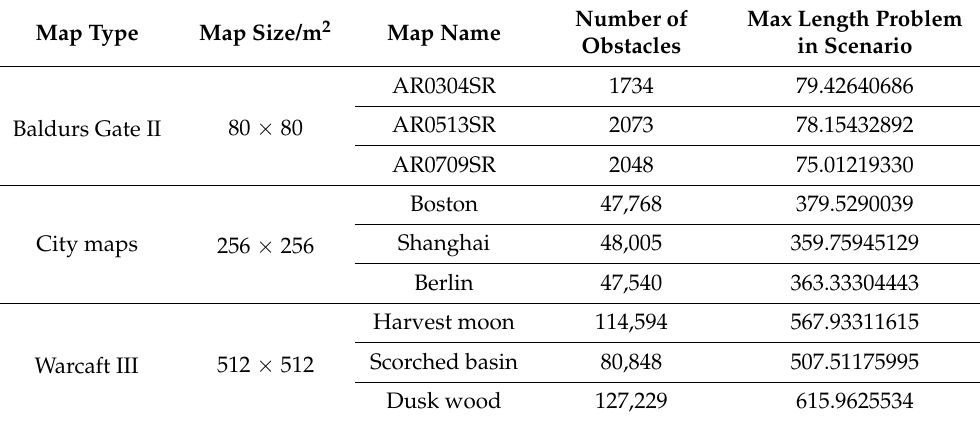
Table 2. Map related information